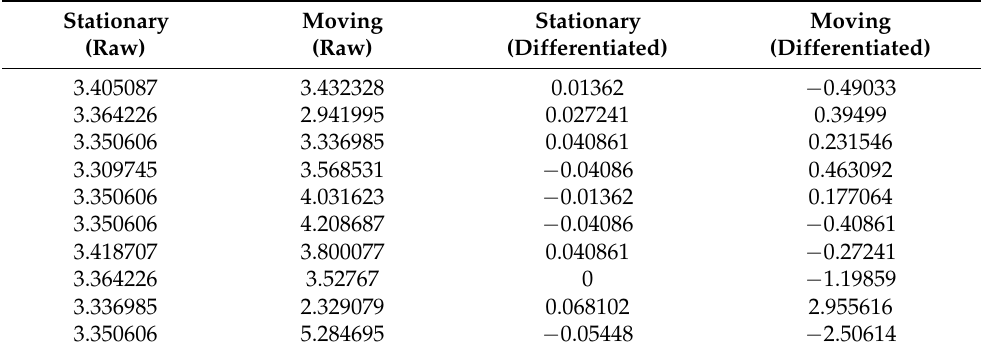
Table 1. Raw vs. differentiated data (unit: m/s 2